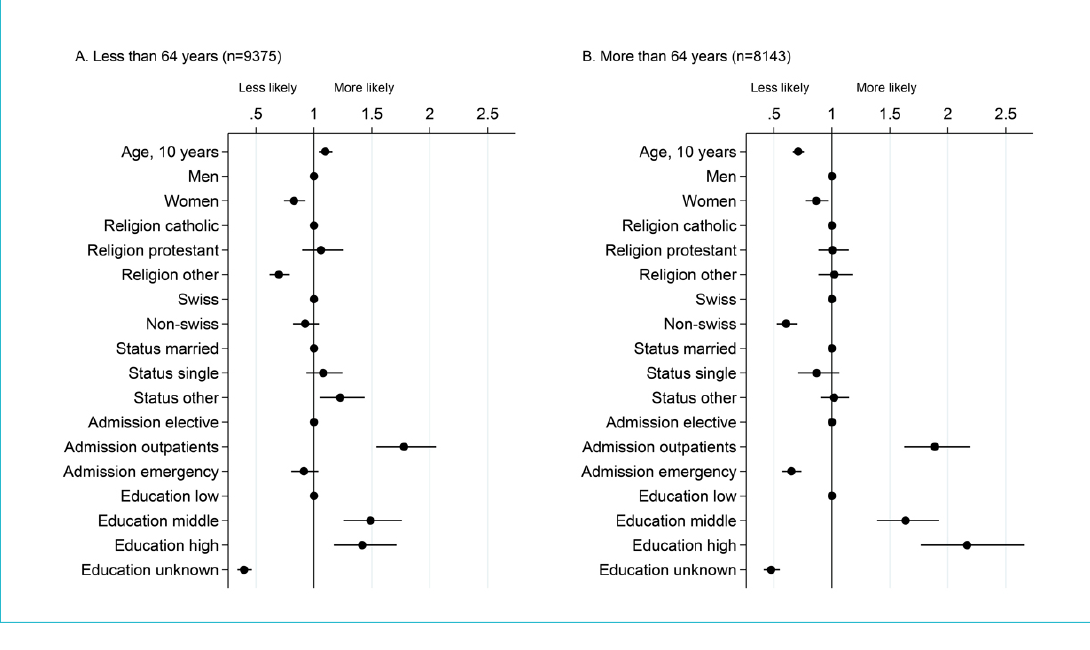
Figure S2: Factors associated with willingness to participate, among patients with information available on education level . This analysis is restricted to the 17 518 patients for whom information on education level is available (this information was collected from 2014). Dots represent odds ratios and bars 95% confidence intervals from a multivariable logistic model including willingness to participate as the de- pendent variable, run separately in the two age strata.